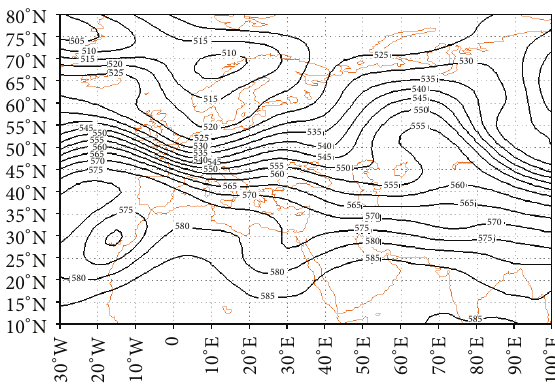
Figure 8: 500 HPa geopotential height level map.